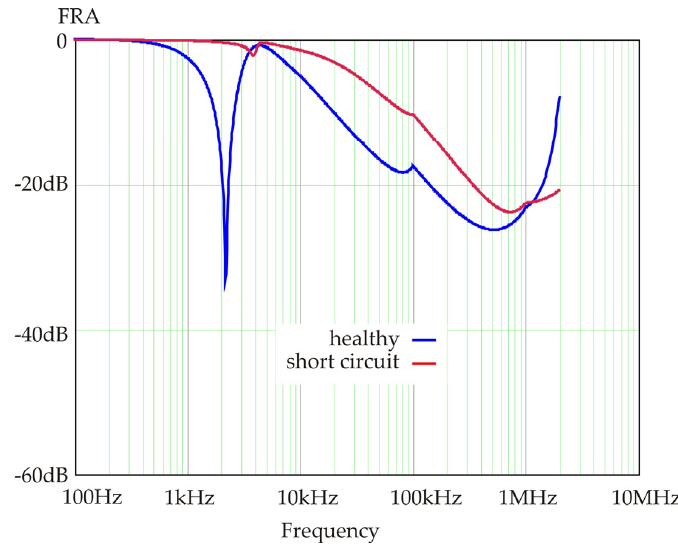
Figure 11. Frequency response of the model for the healthy case (blue line) and with a simulated short circuit between discs 9 and 10 (red line).